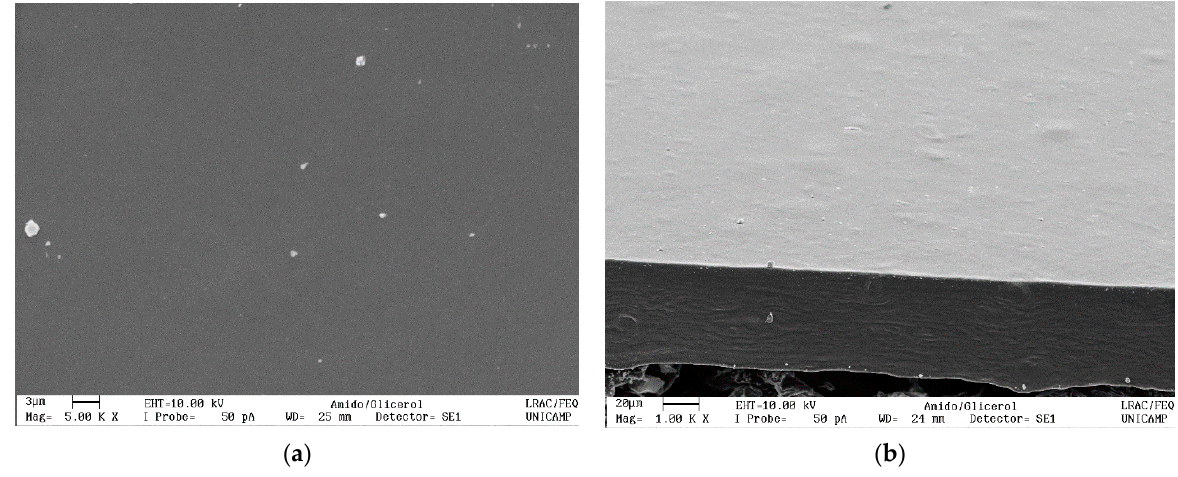
Figure 2. Scanning electron microscopy (SEM) images: ( a ) surface and ( b ) cross section of the film produced with 4% (mass/mass) of arrowroot starch and 15% of glycerol (mass/mass of starch).